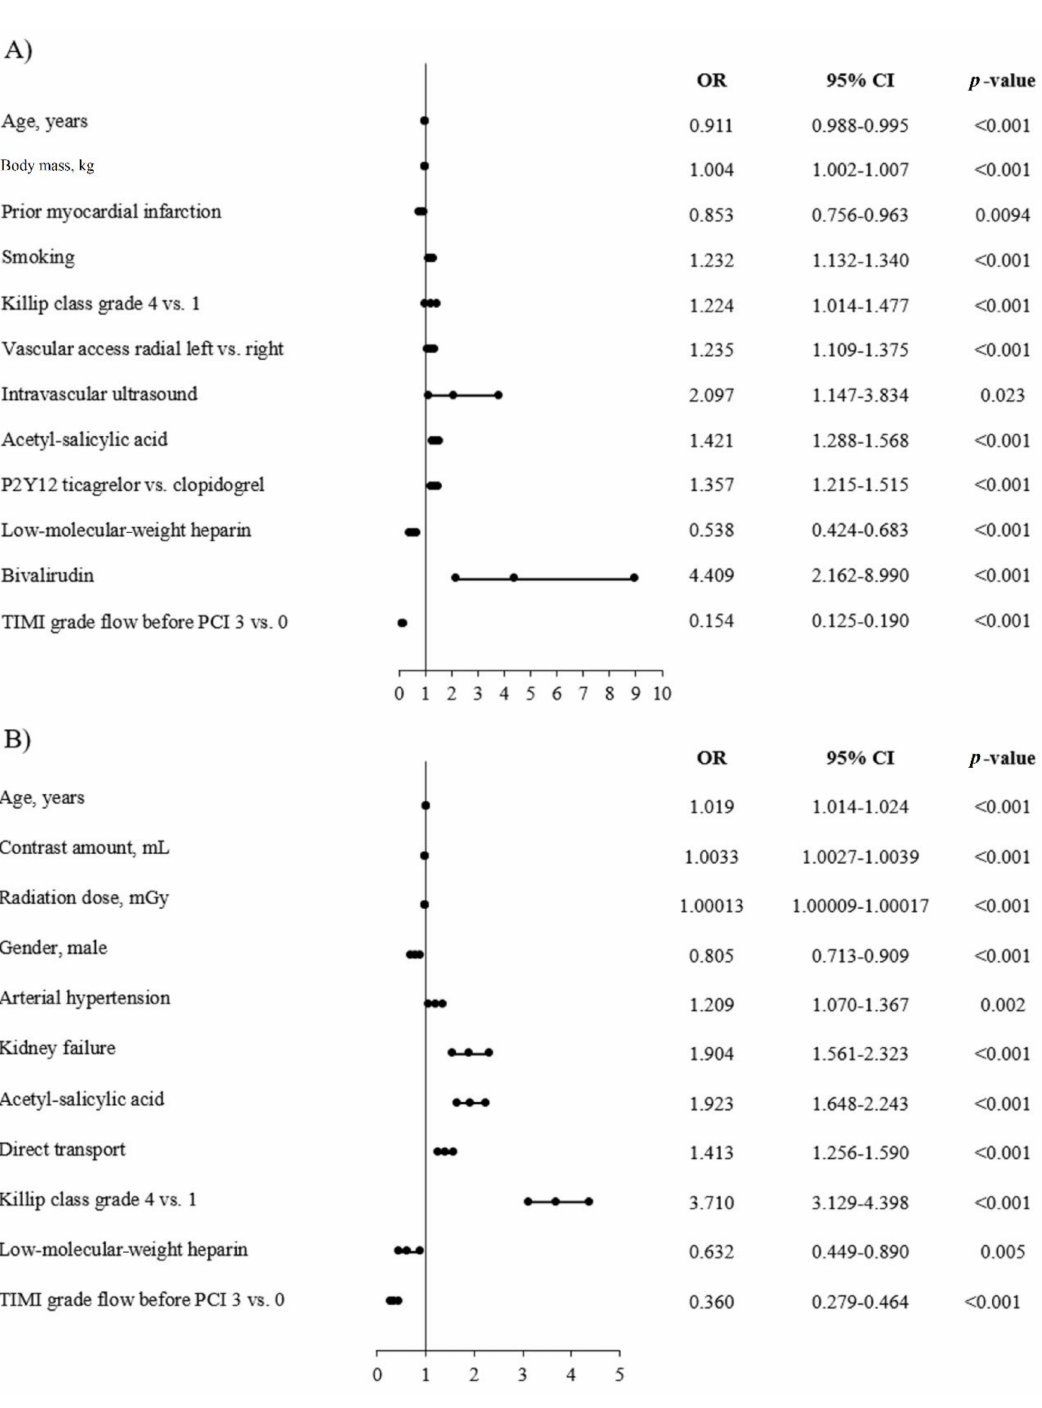
Figure 3. Predictors of TA and no-reflow phenomenon in the STEMI subgroup. ( A ) Thrombus aspiration. ( B )